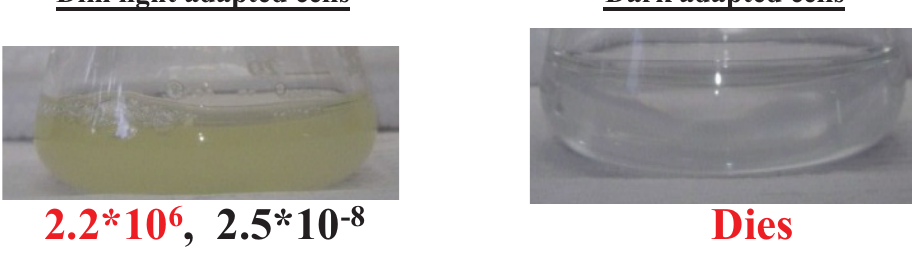
Figure S1. Effect of light shift on the growth of 6F14 and wild type. 6F14 was adapted to dim light (10–15 µmol photons m -2 s -1 ) or dark for one week in TAP media. Dark and dim light adapted cultures were then shifted to 40–50 or 75–80 µmol photons m -2 s -1 . The mean cell density (cells/ml) and the Chlorophyll (Chl) content (nmol Chl per cell) are shown below the culture flasks in red and black numbers, respectively. For each light condition, experiments were performed on three biological replicates of 6F14 . Statistical error (±SD) was ≤ 10%. The average Chl content in the dim light and dark adapted 6F14 was 1.7 × 10 -6 and 2.18 × 10 -6